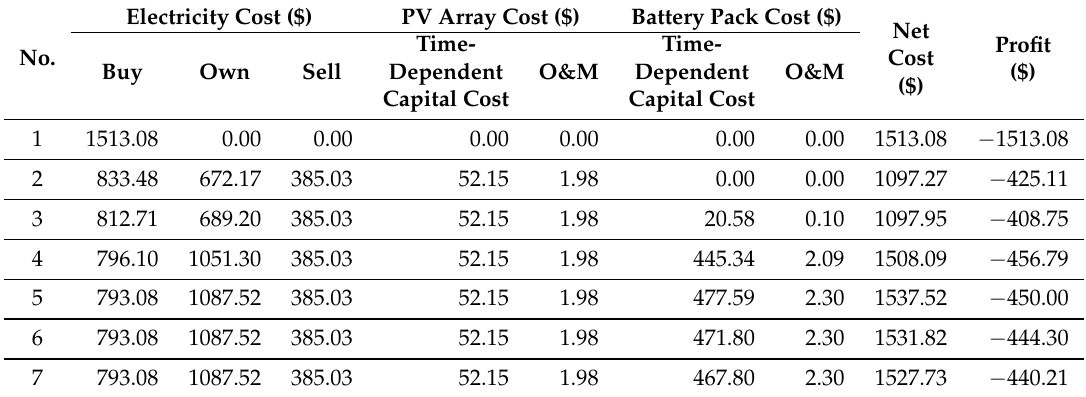
Table 8. Cost quantities simulation results of one-year period with different battery packs in the EV.